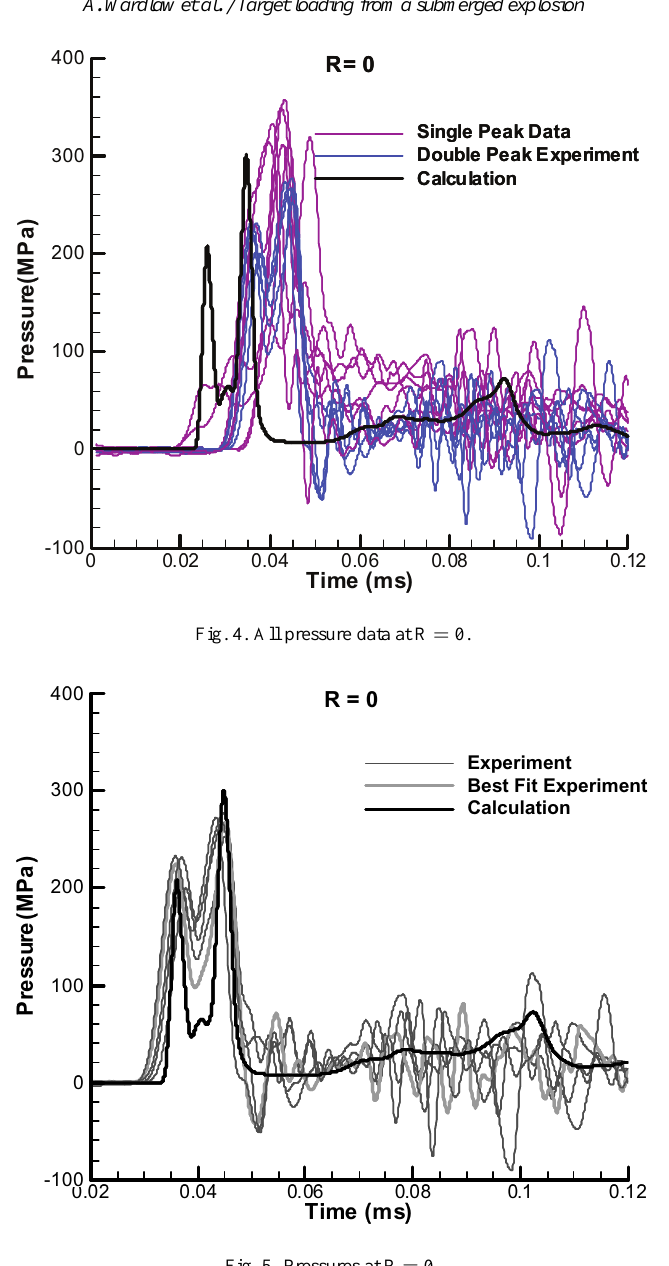
Fig. 5. Pressures at R =